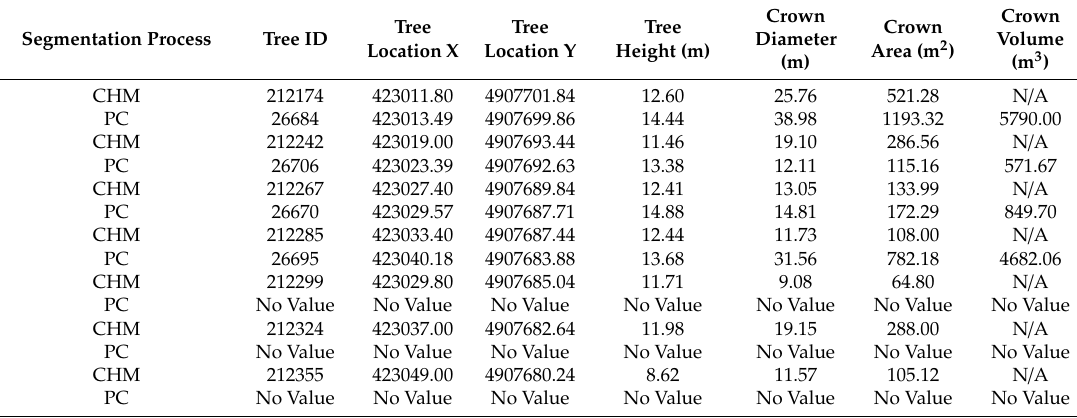
Table 8. LiDAR tree attributes from sample area using the canopy height model (CHM) and point cloud (PC)